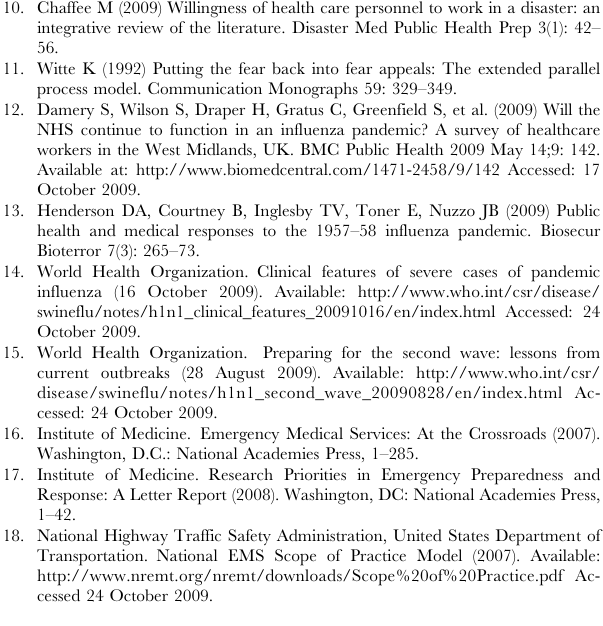
Table S1 Weighted chi-square analyses to evaluate the associ- ations between EMS clinical service provider characteristics and influenza immunization in last 12